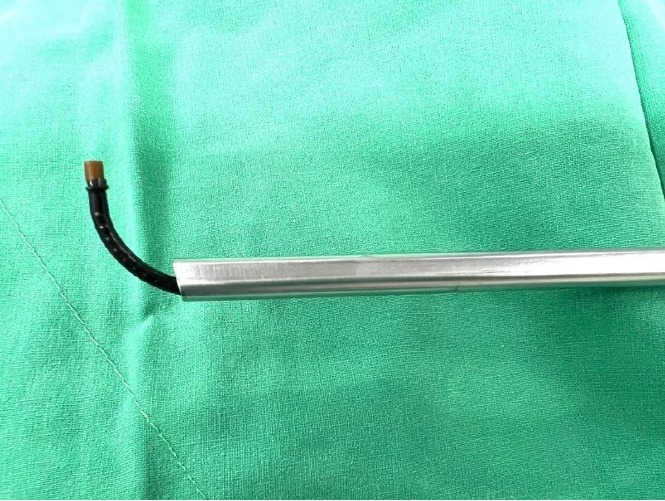
Figure 4. Flexible ureteroscope working extent.